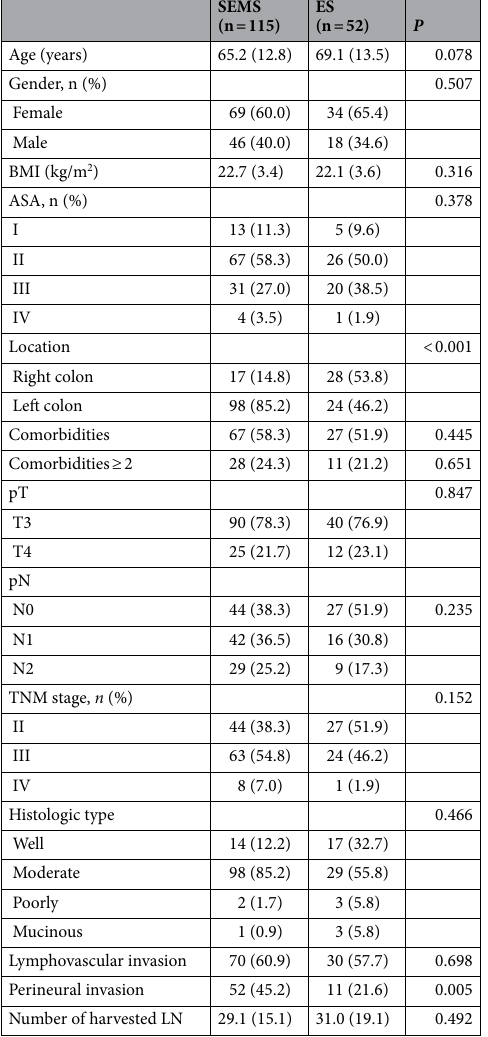
Table 1. Patient characteristics in obstructive colorectal cancer. Data are presented as the number of patients (%) or mean (standard deviation) unless otherwise stated. SEMS self-expandable metallic stent, ES emergent surgery, n number, BMI body mass index, ASA American Society of Anesthesiologists, LN lymph